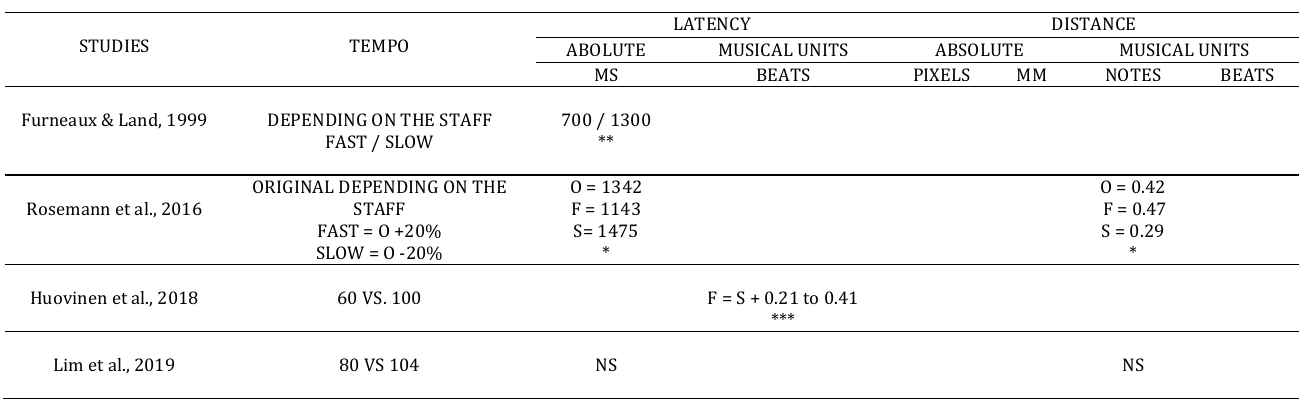
Table 5. Eye-Hand Span as a function of